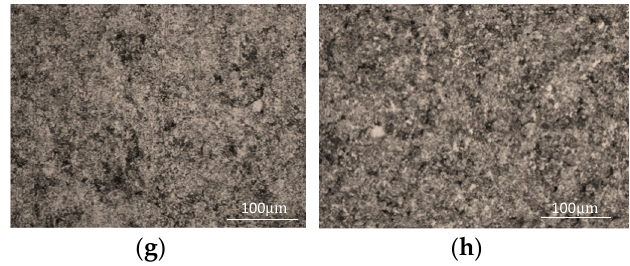
Figure 2. Microstructure of AISI 410 steel treated at different temperatures for 1 h and then oil quenched at ( a ) 800 °C, ( b ) 820 °C, ( c ) 840 °C, ( d ) 860 °C, ( e ) 880 °C, ( f ) 900 °C, ( g ) 930 °C, and ( h ) 970 °C, respectively.